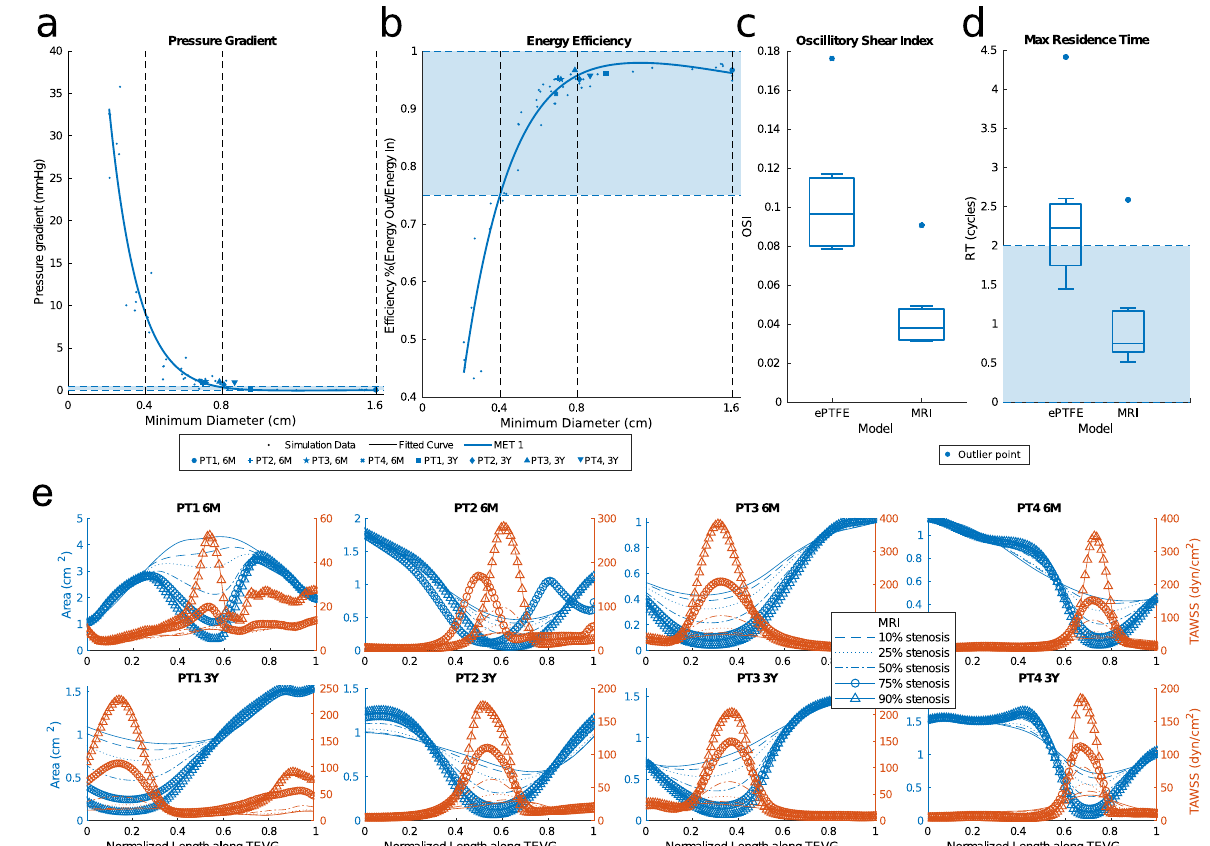
Fig. 8 Local hemodynamics of simulated and MRI measured graft geometries. a Pressure gradient across the Fontan graft at MET1. b Energy ef fi ciency of the TCPC at MET 1 with reference values of 75 – 100% indicated by the shaded region. c Box plot of OSI at MET 1 showing quartiles and outliers. d Box plot of max RT at MET 1 showing quartiles and outliers. e Wall shear stress compared to cross-sectional area over the length of TEVGs at various stenosis